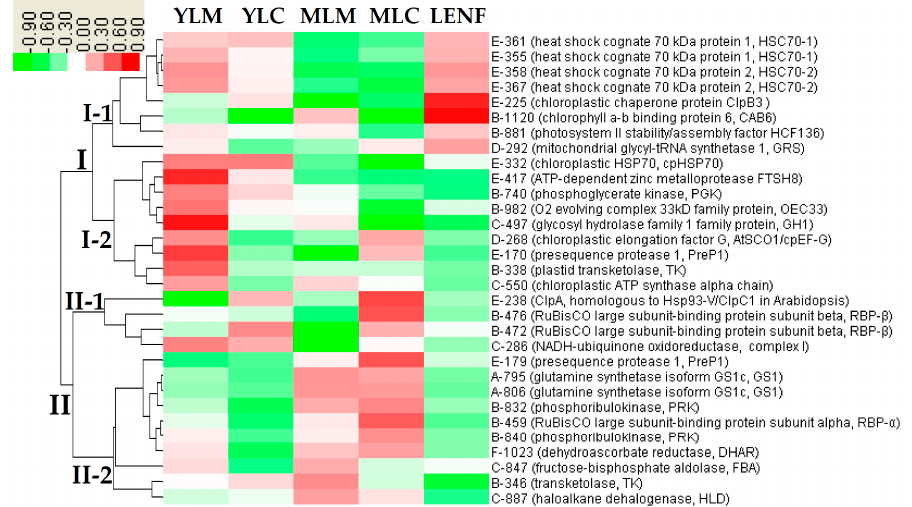
Figure 8. Hierarchical clustering analysis of the expression profiles of the identified 31 proteins. The five columns represent various leaf regions at different development stages of Hosta “Gold Standard”, including young leaf margin (YLM), young leaf center (YLC), mature leaf margin (MLM), mature leaf center (MLC), leaf under excess nitrogen fertilization (LENF). The rows represent individual proteins. Two main clusters (I and II) and subclusters of I (I-1 and I-2) and subclusters of II (II-1 and II-2) are shown on the left side. Functional categories indicated by capital letters, spot numbers, and protein names are listed on the right side. The scale bar indicates log (base2) transformed protein abundance ratios ranging from − 0.9 to 0.9. The ratio was calculated by dividing percent volume (vol %) of each protein spot at various leaf region samples by the average vol % of the five various leaf region samples of the same protein spot. The increased and decreased proteins are represented in red and green, respectively. The color intensity increases with increasing abundant differences. Functional categories: